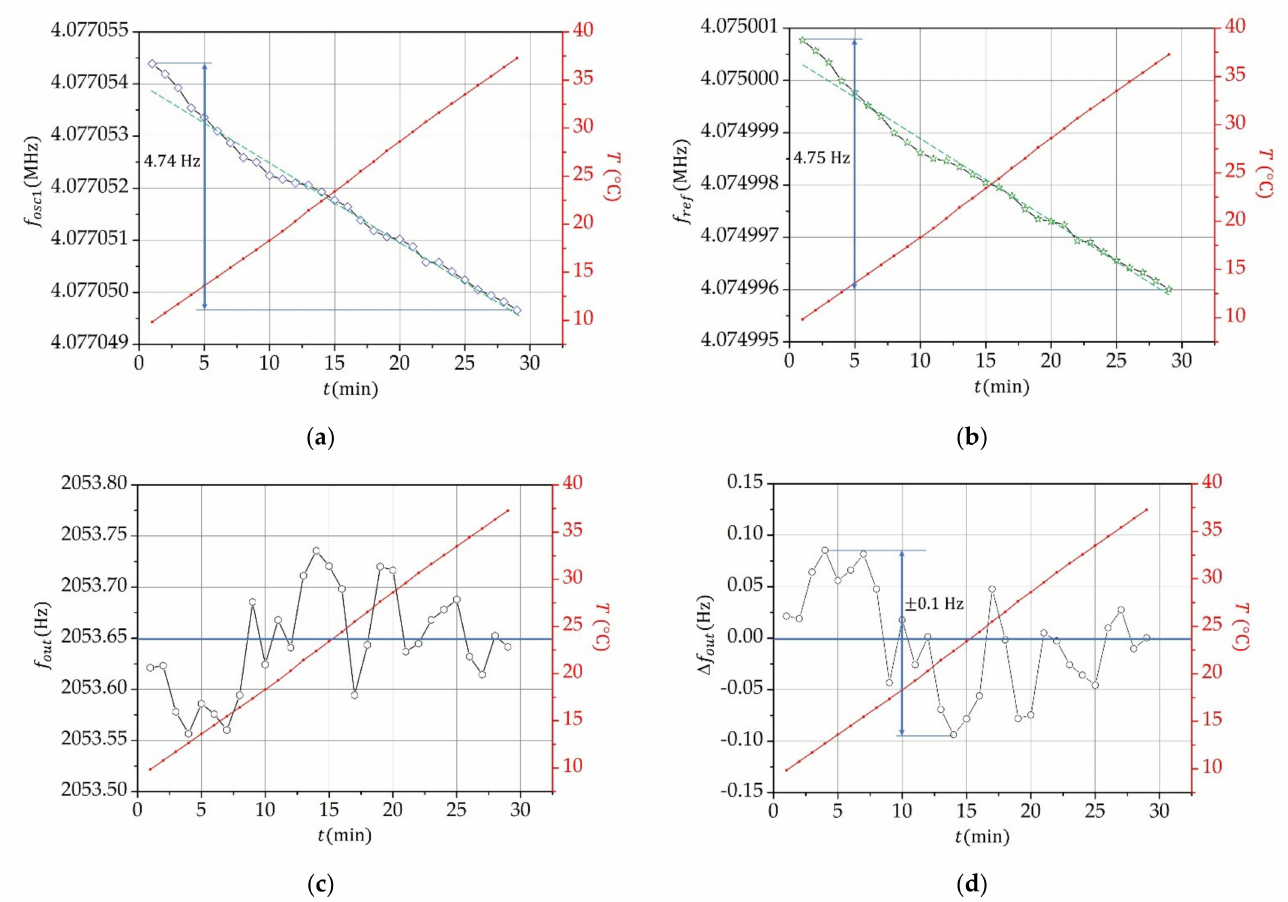
Figure 3. Oscillator’s frequency variation in relation to the temperature variation (10–40 ◦ C). The temperature was increased uniformly from 10–40 ◦ C in a time span of 30 min (red dashed line). (a,b) Variation of the oscillator frequencies f osc 1 and f ref . The green dashed line presents the trend. (c) Frequency difference, f out , between the two oscillators. (d) Variation of the frequency difference, ∆ f out , between both oscillators in relation to the mean value of 2053.65 Hz (blue line in Figure